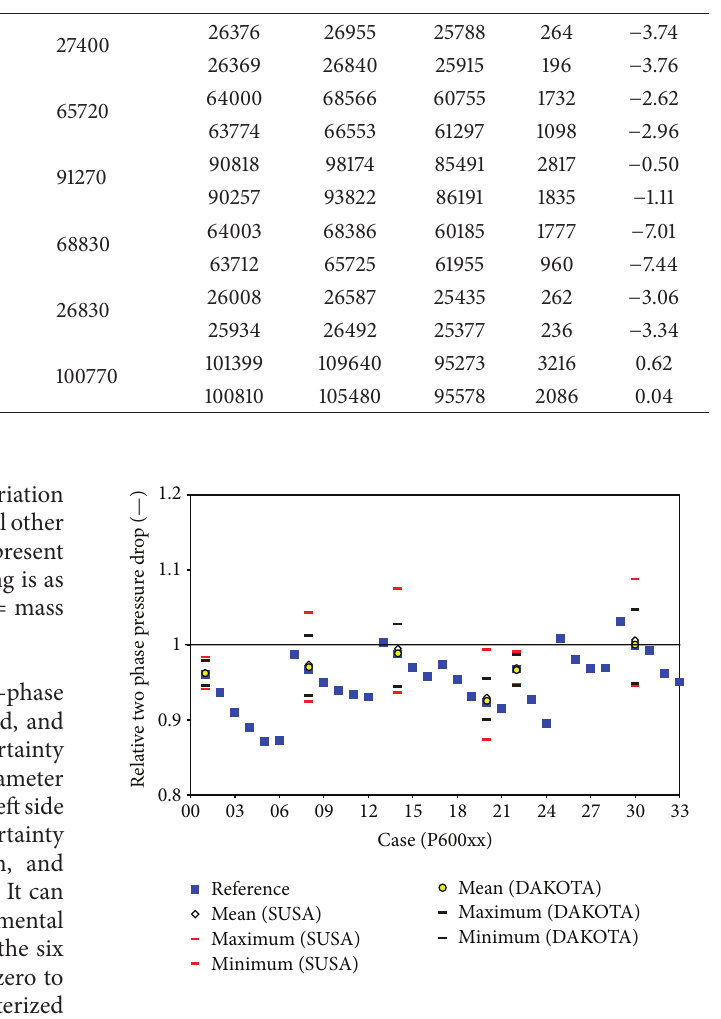
Figure 4: Relative two-phase flow pressure drop and uncertainty band for TRACE-SUSA and